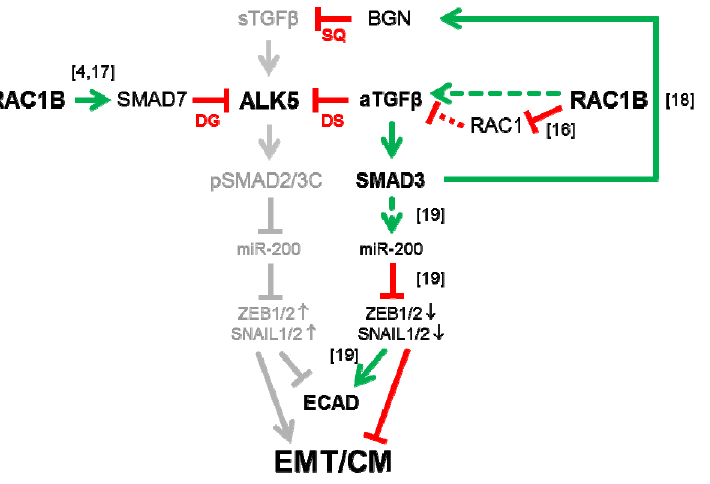
Figure 6. Cartoon illustrating the pathways through which RAC1B targets TGF β and its receptors for inhibition in PDAC / TNBC-derived cells. Left, RAC1B promotes expression of SMAD7 and SMAD7-mediated degradation (DG) of ALK5. Right, RAC1B—in a RAC1-dependent or independent manner (see Discussion)—promotes expression and secretion of endogenous / autocrine (aTGF β 1). Its occupation of surface receptors induces their rapid internalization and because receptors are replenished only very slowly the cells adopt a refractory state (desensitization, DS) against acute stimulation with paracrine, stromal cell-derived TGF β (sTGF β ). The sTGF β activates ALK5 which phosphorylates SMAD2 and SMAD3 at their C-terminus (pSMAD2 / 3C), while aTGF β 1—in addition to its e ff ects on receptor turnover—upregulates SMAD3 mRNA and protein abundance. Both pathways converge on the miR-200 / ZEB1 autoregulatory loop via intermittent transcriptional activation of miR-200 family members to decrease (pSMAD2 / 3C) or increase (SMAD3) ECAD expression and to stimulate (pSMAD2 / 3C) or repress (SMAD3) EMT and cell migration (CM) (denoted by arrows or lines). Upper right, The RAC1B-aTGF β 1-SMAD3 pathway may also induce BGN, which prevents receptor activation by sequestration (SQ) of sTGF β in the TME. Arrows indicate induction / activation and lines repression / inhibition. Stippled red lines denote a still hypothetical interaction. The bracketed numbers next to arrows / lines denote relevant